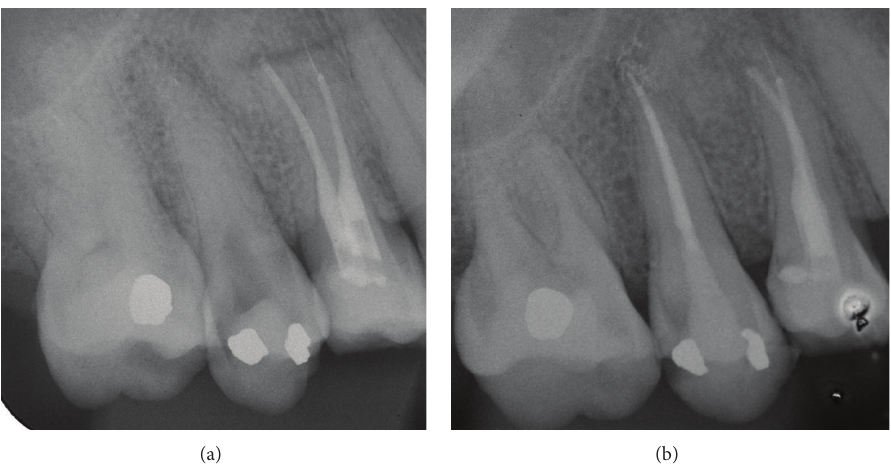
Figure 3: (a) Initial radiograph showing constricted canals. (b) Final radiograph.